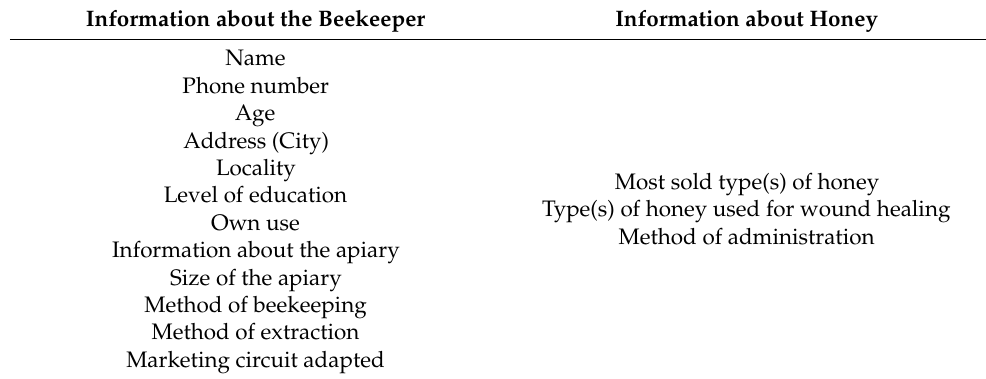
Table 2. Questionnaire intended for beekeepers/honey used for wound healing in Morocco. Information about the